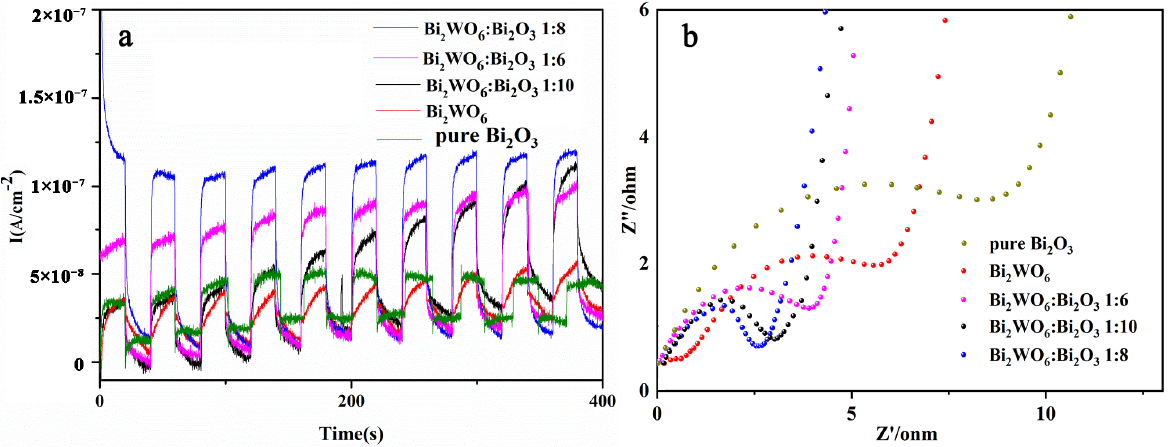
Figure 6. Photocurrent response ( a ) and EIS spectra ( b ) of Bi 2 O 3 and Bi 2 WO 6 /Bi 2 O 3 at different ratios.